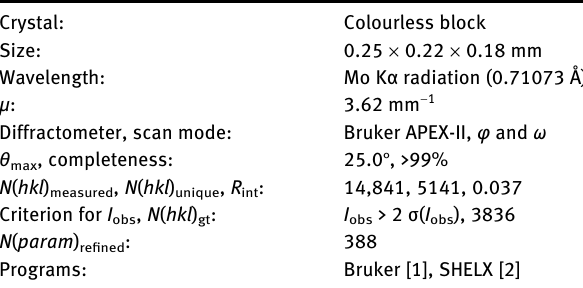
Table  : Data collection and